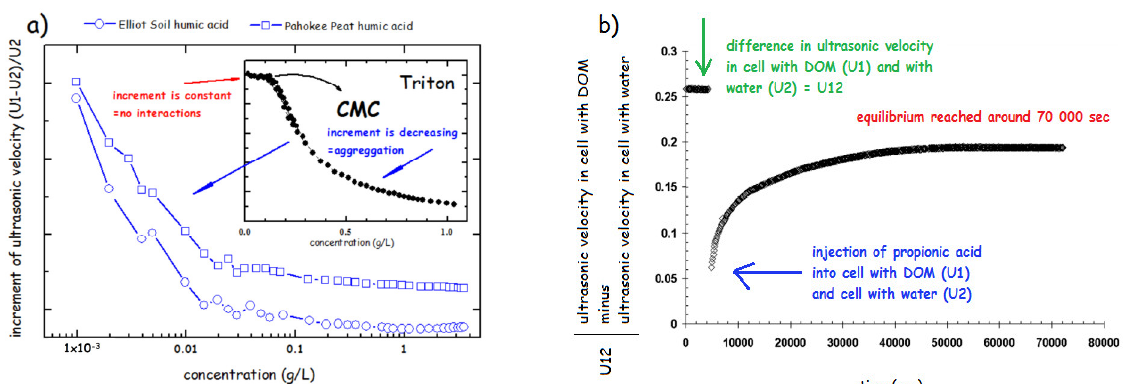
Figure 7. ( a ) Comparison of aggregation behavior of DOM and triton using increment of ultrasonic velocity (based on the results of ref. [180]). ( b ) Kinetic curve—ultrasonic velocity corresponding to the reconformation of DOM after addition of propionic acid as indicated by the change in U 12 , which is the difference between cell 1 with DOM sample and cell 2 filled with water (based on the results of ref. [47]).